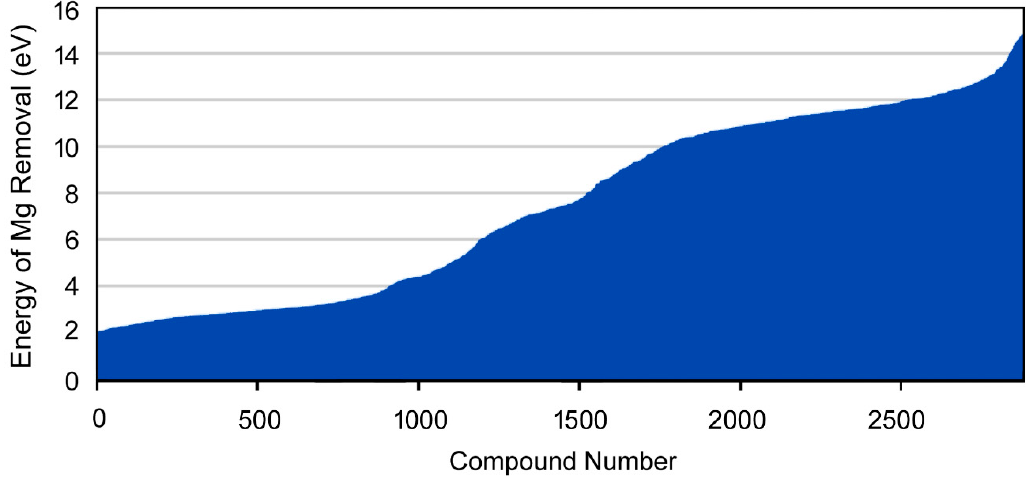
Figure 15. Computed descriptor related to magnesium binding energies (eV) for a range of experimentally known magnesium compounds. This screening survey highlights different classes of materials containing magnesium, thus providing a quantitative comparison of the chemical bonding between host structure and the magnesium within each system.